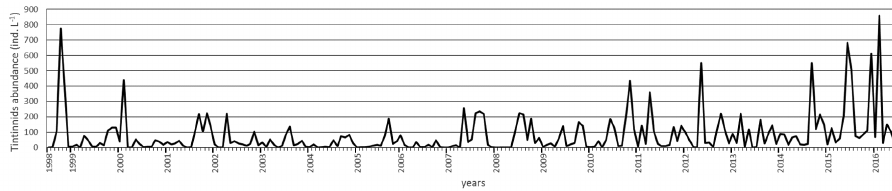
Figure 2. Long-term fluctuations of total tintinnid abundance (ind. L -1 ) integrated within the water column (0–15 m) from July 1998 to July 2016 in the Gulf of